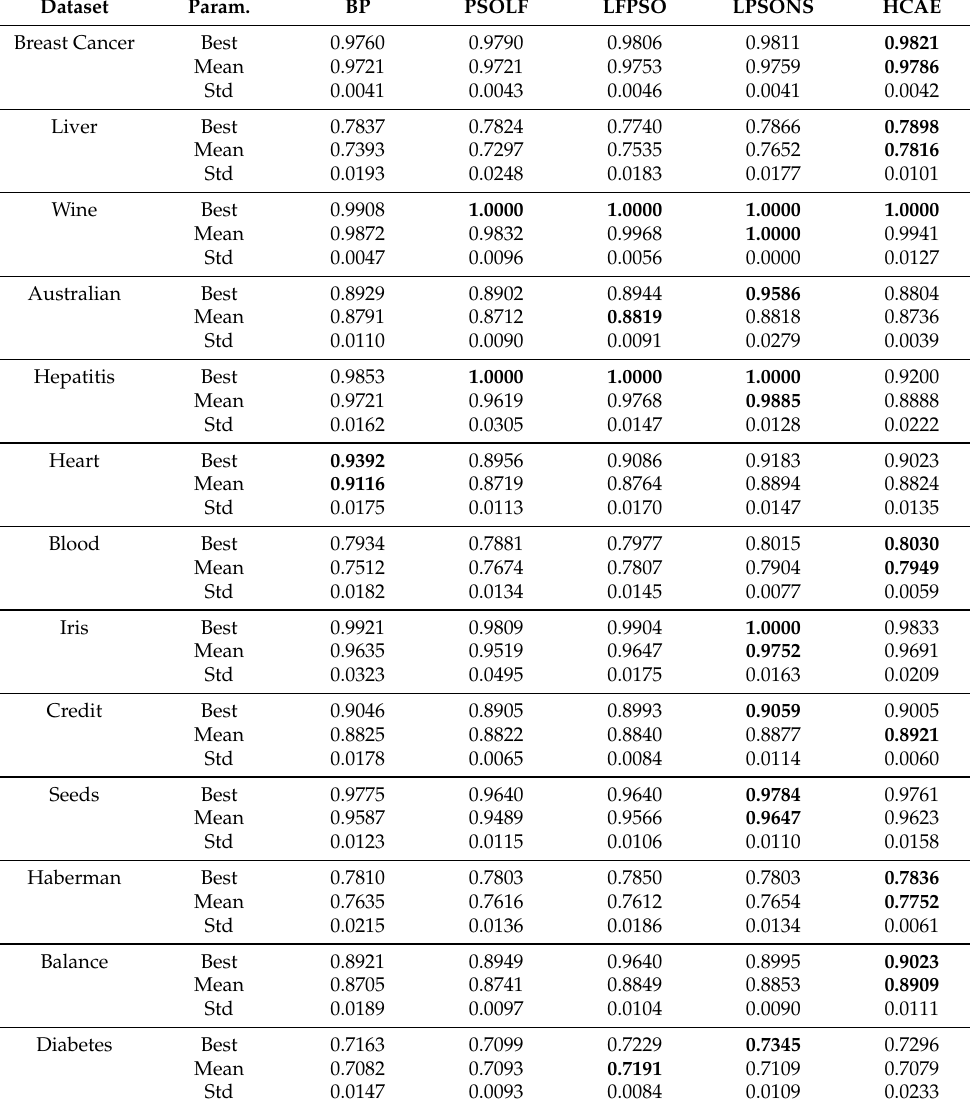
Table 8. Classification training accuracy (results of BP, PSOLF, LFPSO, and LPSONS taken from